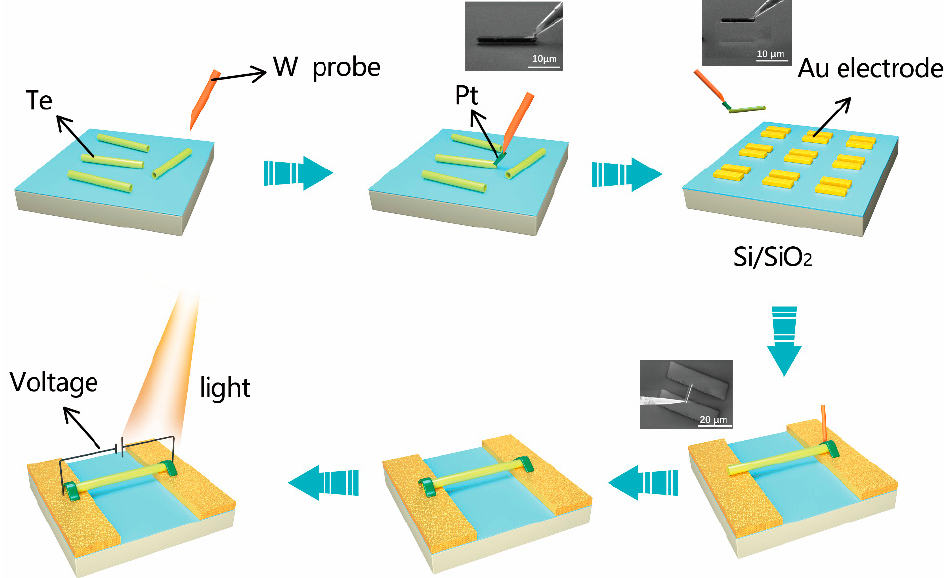
Figure 1. The schematic illustration of the fabrication process of individual Te nanotube photodetector assisted by FIB technique. Insets are SEM images taken during the fabrication process.